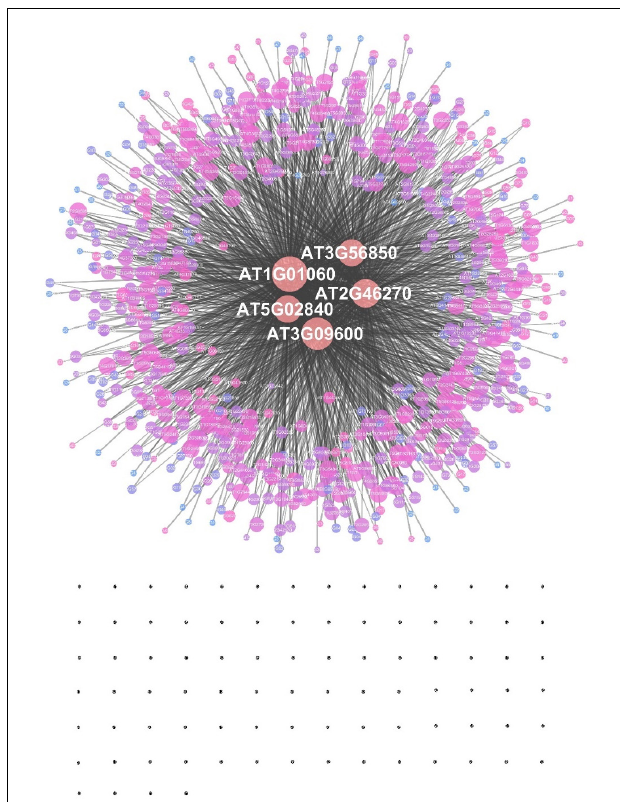
FIGURE 2 | An example of a transcription factor regulatory network constructed by EAT-UpTF. A set of target genes of the LHY transcription factor (Adams et al., 2018) was used as a test input. The area of a node represents the edge count and the color intensity indicates the strength of the neighborhood connectivity. Black dots represent single